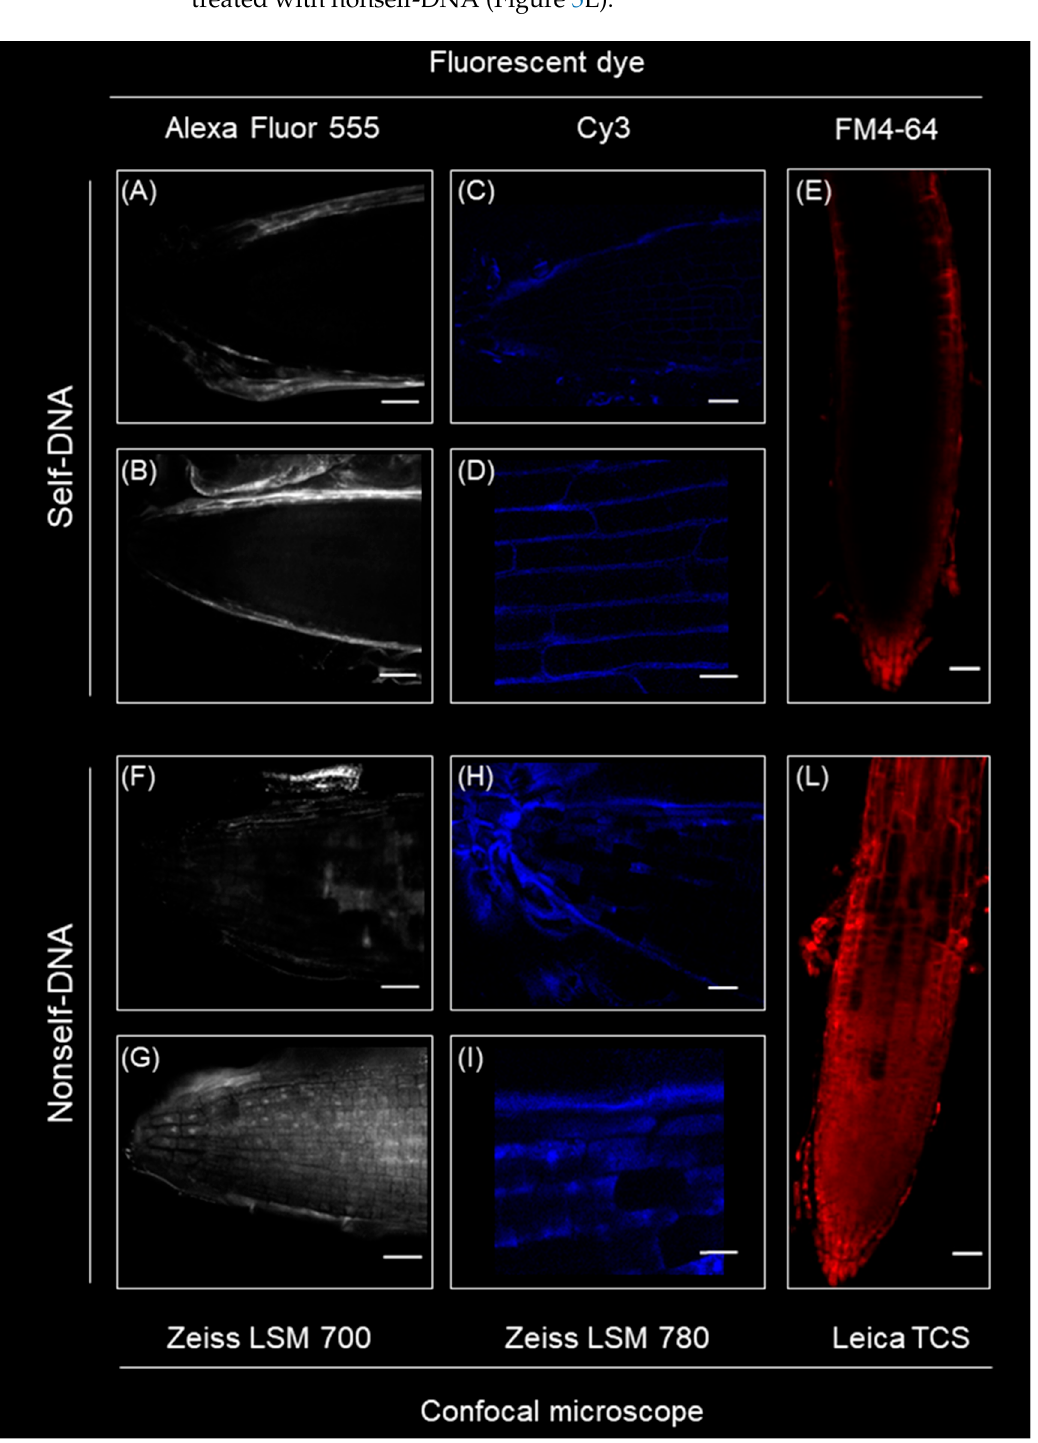
Figure 5. Fluorescence microphotography (confocal images) of early response (1 h) to self- vs. nonself-DNA treatments. From the left to the right, the following treatments are shown: Alexa Fluor 555 dye (in white) labelling self-DNA ( A , B ) and nonself-DNA ( F , G ); Cy3 dye (in blue) labelling self-DNA ( C , D ) and nonself-DNA ( H , I ); FM4-64 staining (in red) of A. thaliana roots after 1 h exposure to either self-DNA ( E ) or nonself-DNA ( L ). Scale bars 20 µ m in ( A – C , E – G , I , L ); 10 µ m in ( D , H ).